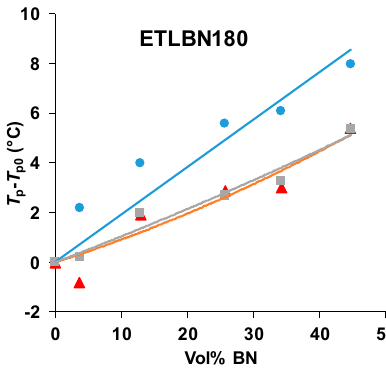
Figure 3. Peak temperature during non-isothermal cure relative to that for the unfilled system, T p − T p0 , as a function of BN content for di ff erent platelet sizes, as indicated, and for di ff erent heating rates: 10 K/min, blue circles; 5 K/min, red triangles; 2 K/min, grey squares.